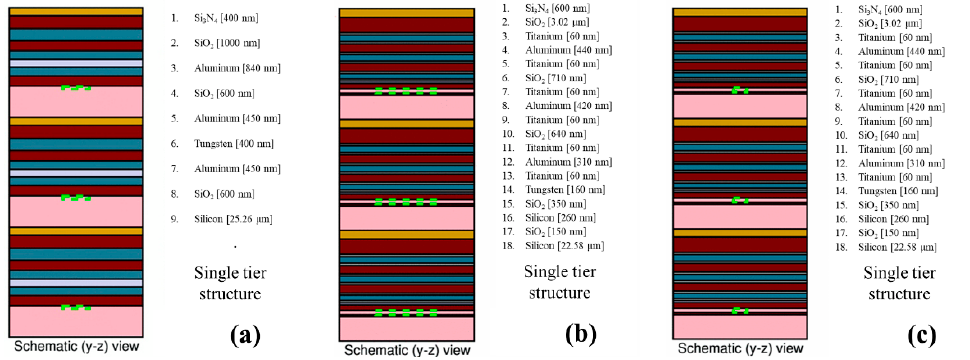
Figure 2. Three-tier stacked models for simulation based on the process of ( a ) 180-nm radiation-hardened SRAM, as well as the 130-nm silicon on insulator (SOI) SRAM with ( b ) 6T structure and ( c ) ADE-hardened design.